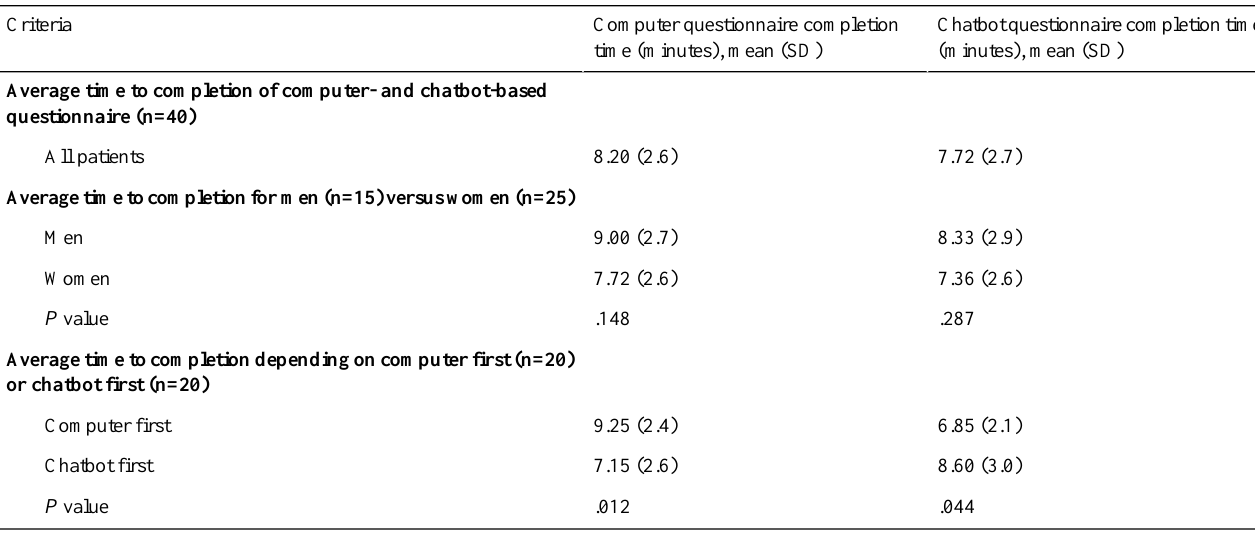
Table 1. Time to completion (minutes).